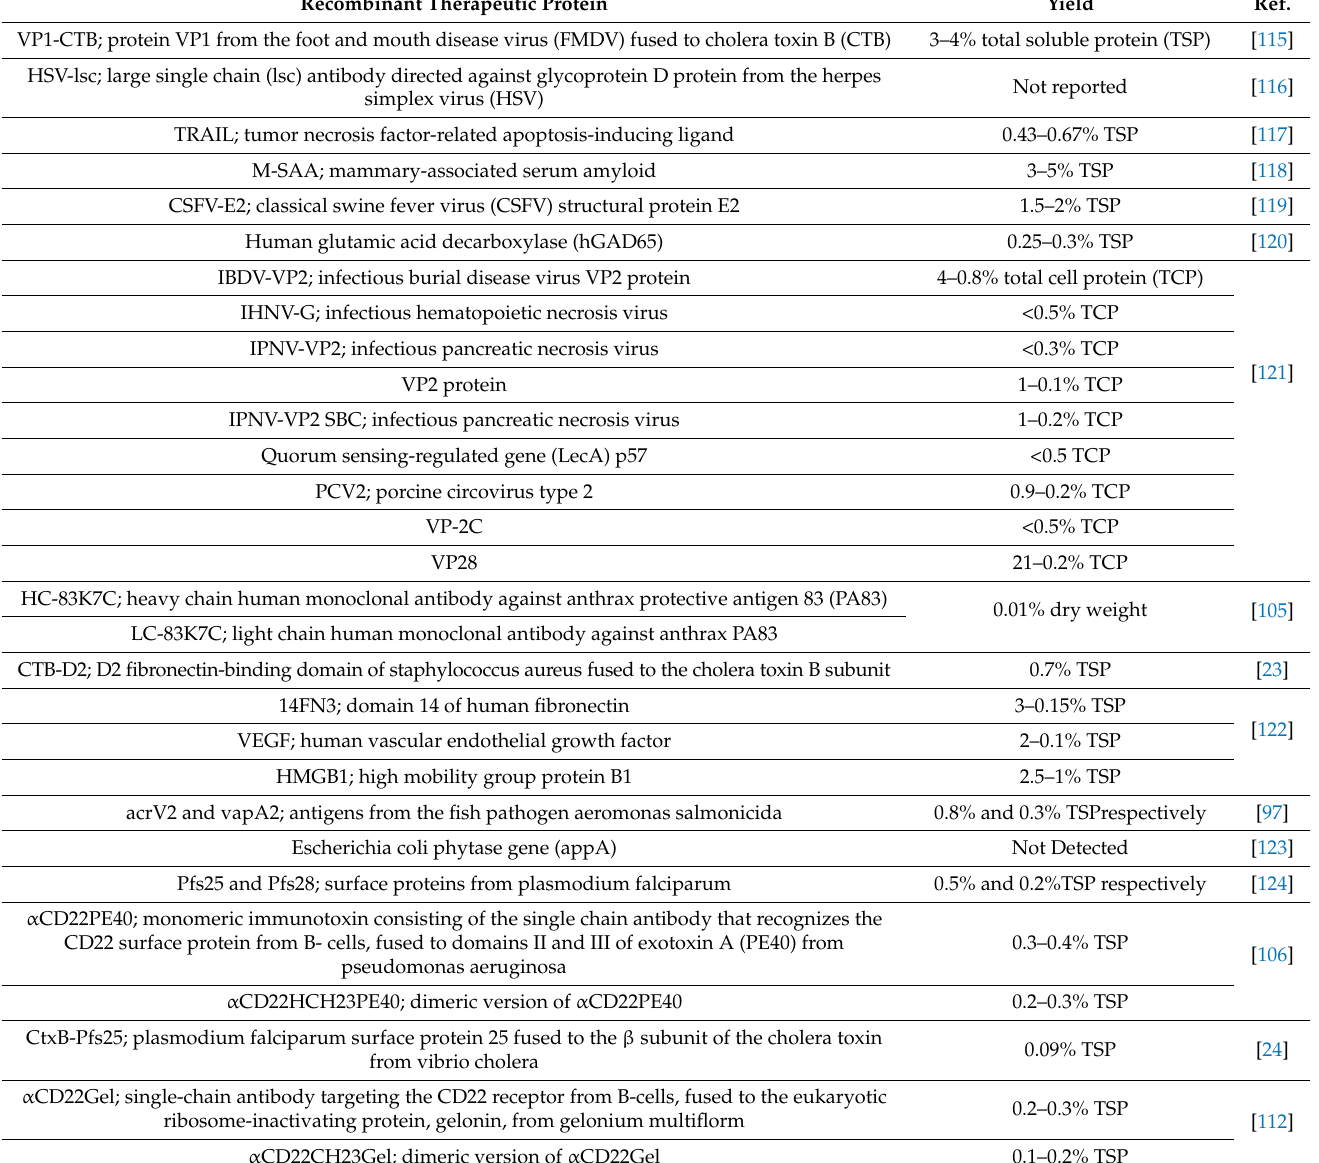
Table 3. Overview of recombinant proteins produced in the chloroplast of C. reinhardtii . Adapted with permission from [114]. Copyright 2014